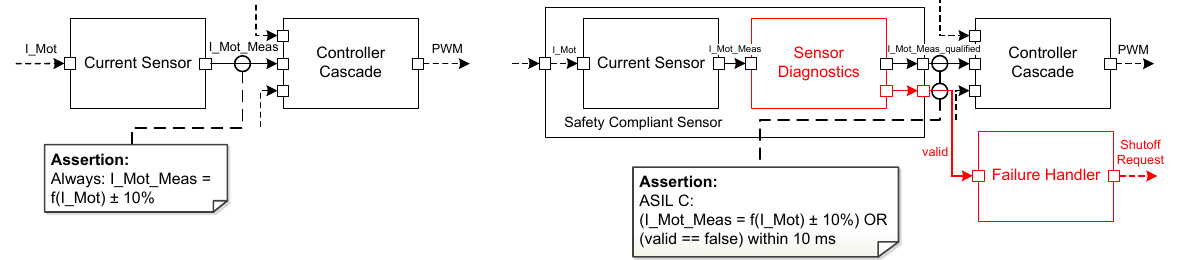
Figure 6. Current Sensor without (left) and with (right) safety